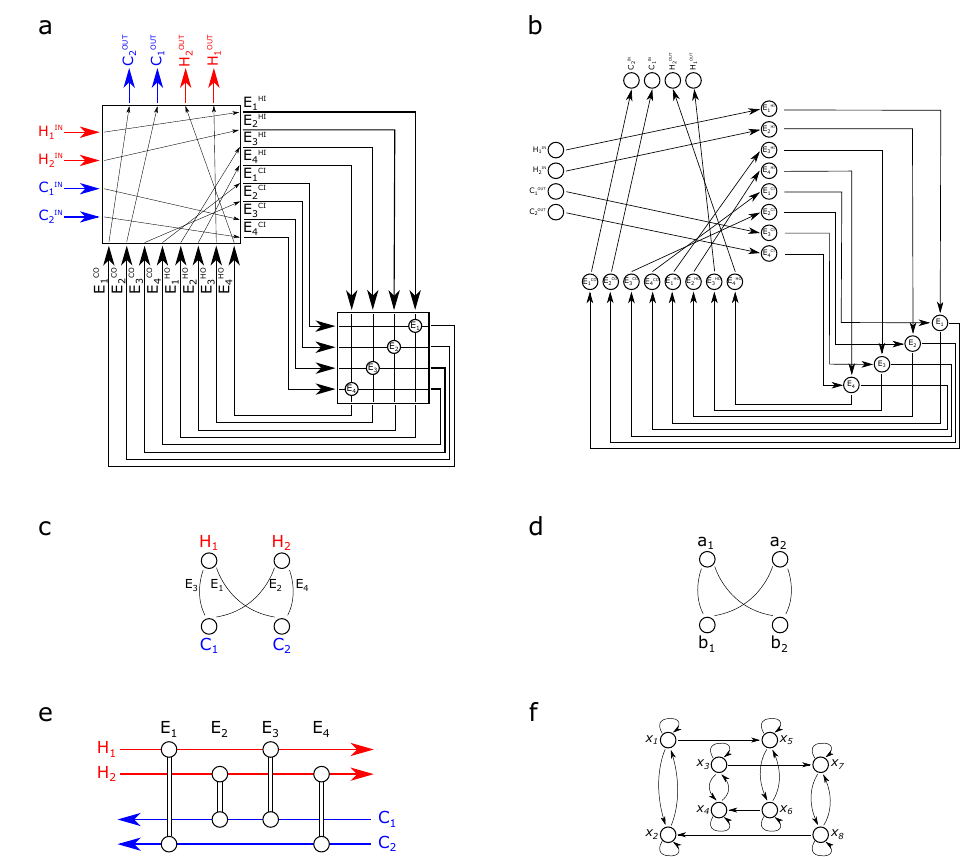
Figure 2. Classical representations of HENs and their graph-based models. The representations are as follows: ( a ) state-space approach (SS); ( b ) network of state-space approach; ( c ) streams and matches (SM); ( d ) bipartite network representation of streams and matches; ( e ) grid diagram; and ( f ) network representation of state